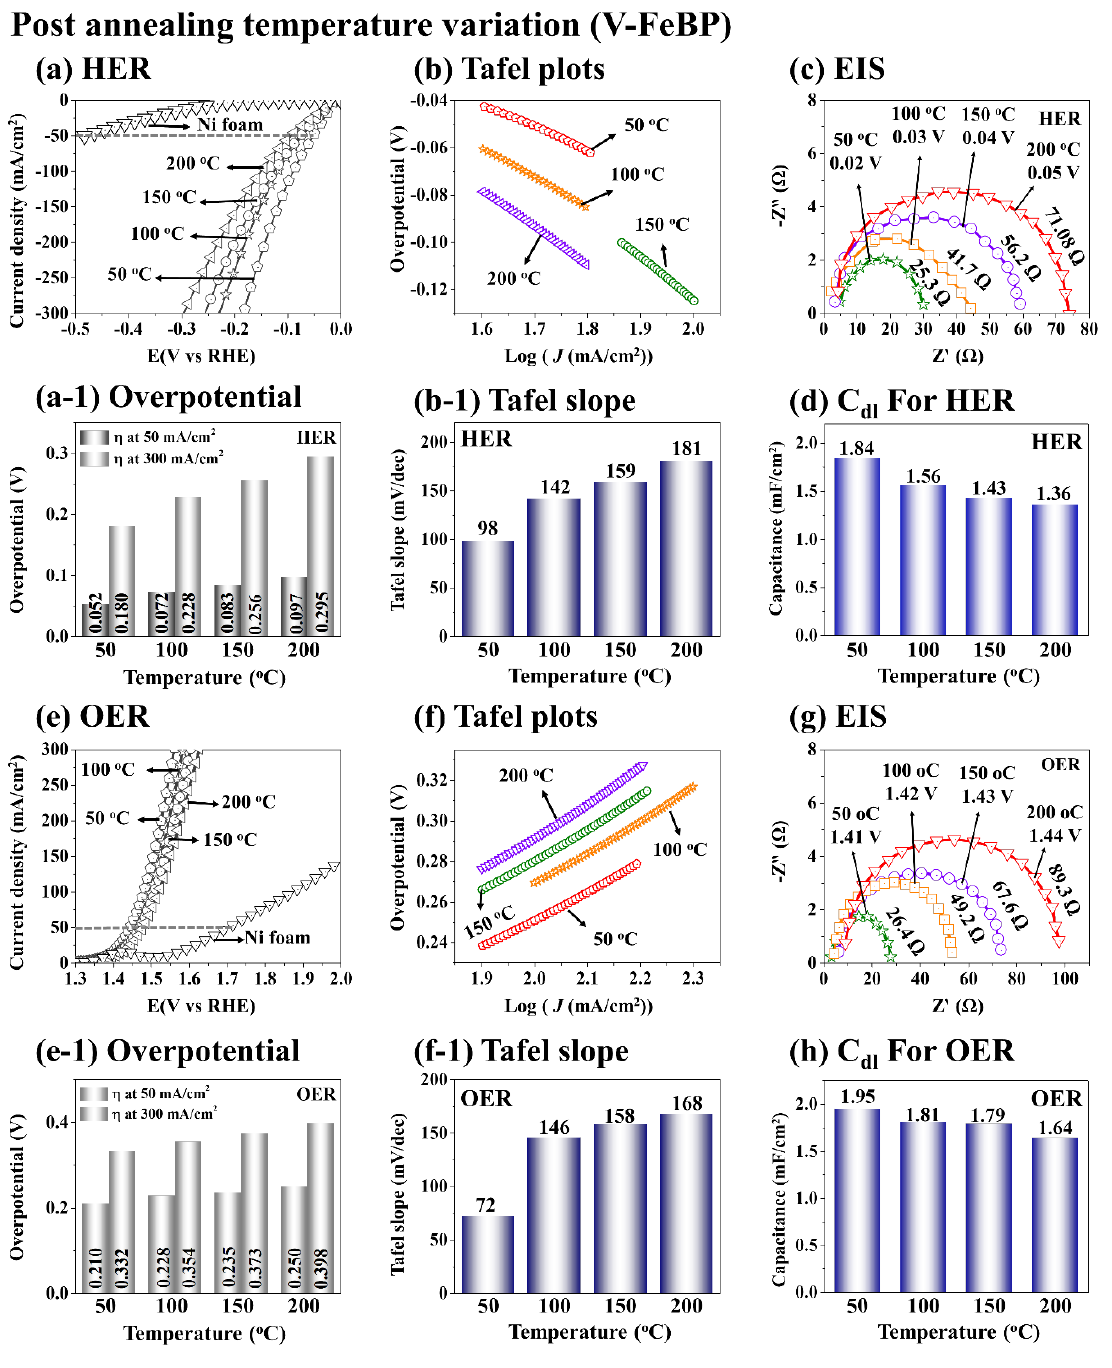
Figure 3. 3-electrode (3-E) electrochemical performance of the post-annealing temperature variation set (V-FeBP MSC electrodes). ( a , e ) HER and OER polarization curves of V-FeBP electrodes in 1 M KOH. ( a-1 , e-1 ) Overpotentials at 50 and 300 mA/cm 2 . ( b , f ) Tafel slopes derived from the polarization curves. ( b-1 , f-1 ) Tafel slope values. ( c , g ) HER and OER Nyquist plots obtained at the fixed current of 20 mA/cm 2 . ( d , h ) HER and OER C dl values. All the electrochemical measurements were plotted as received without iR drop compensation.